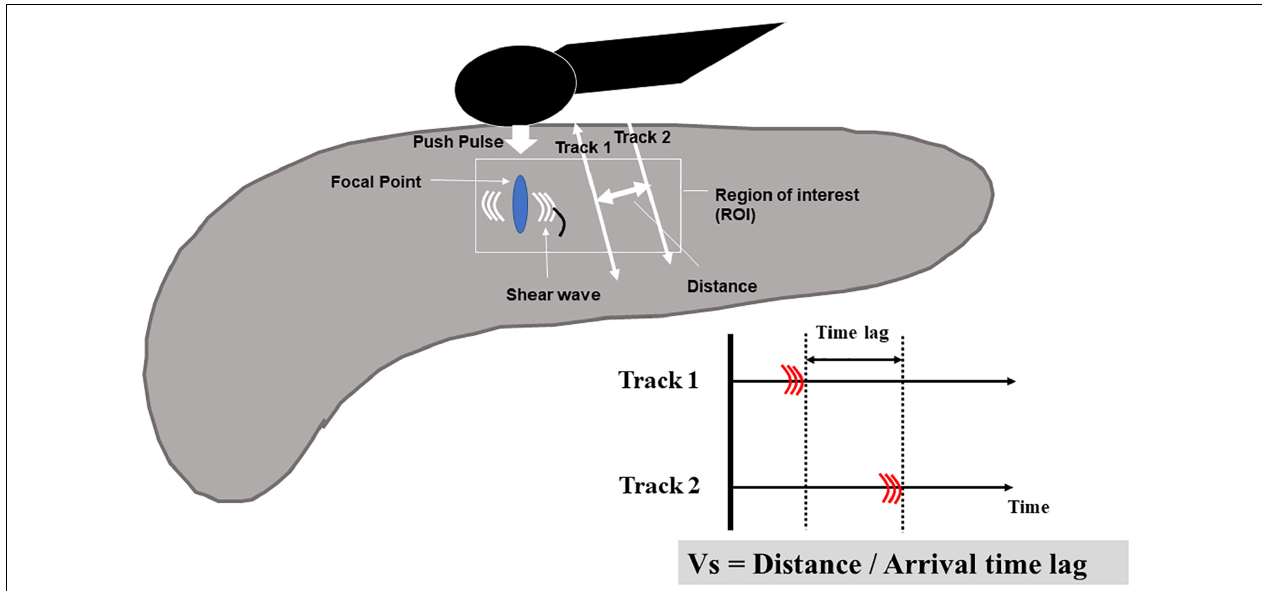
FIGURE 4 | Illustration of EUS shear-wave elastography. Acoustic radiation force (a push pulse) is sent to the focal point of the regions of interest and a shear wave is generated at the edge by this push pulse. The shear wave velocity (distance/arrival time lag [Vs, m/s]) is calculated between two search points with the track pulse.